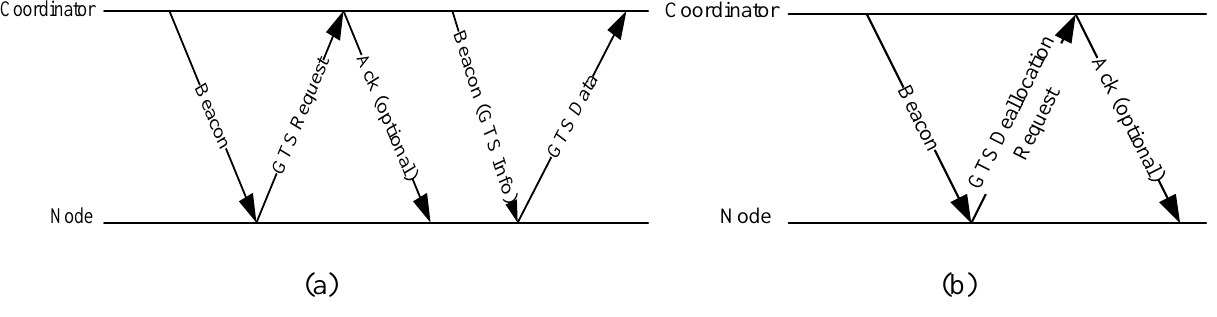
Figure 3. (a) GTS allocation process, (b) GTS deallocation